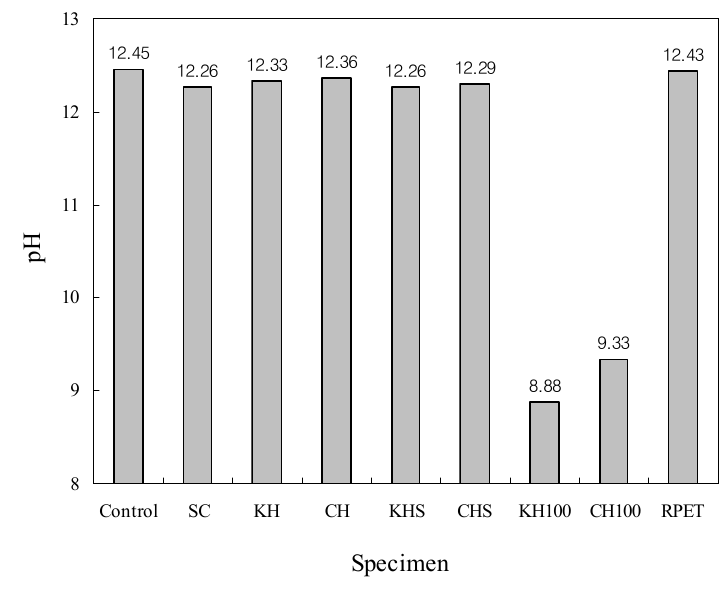
Figure 10. Results of pH